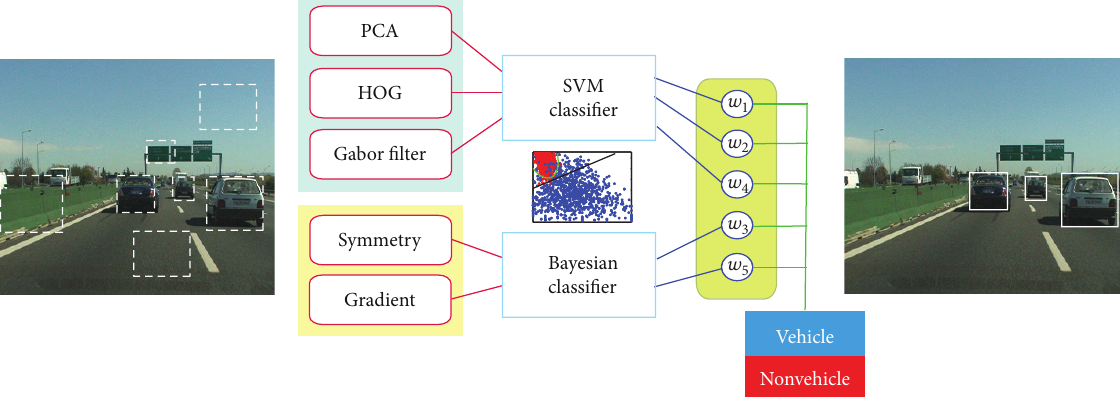
Figure 1: General scheme of the studied fusion approach. A stream of input images is received from a video captured in a traffic scene, together with the potential locations of vehicles (marked through dashed bounding boxes) obtained via an image segmentation technique. The goal is to verify which of them is actually vehicle. To do so, first individual features (PCA, HOG, etc.) are examined, which provide a support for vehicle existence using an associated classifier. Then, a global decision is made according to a classifier fusion